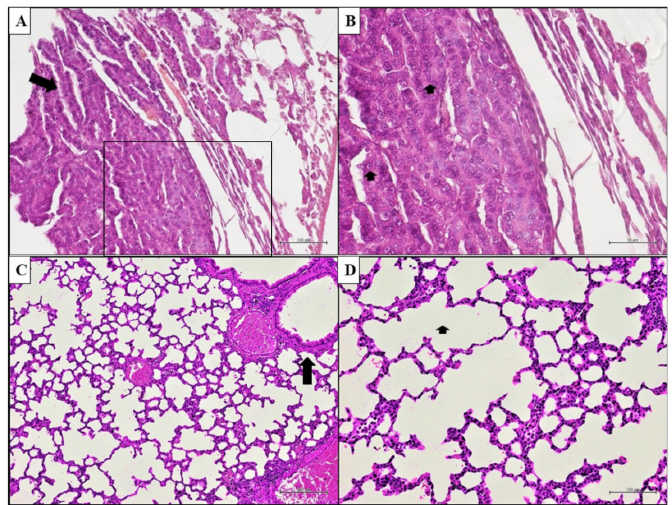
Figure 10. Lung adenocarcinomas in Patz1-knockout mice. ( A ) Representative LUAD with lepidic pattern (left arrow) growing along the surface of the alveolar air spaces of a Patz1 +/ − mouse. The mass is composed of neoplastic cells with loss of polarity, irregularly placed overlapping nuclei, and marked nuclear atypia. ( B ) Higher-power image of the sample shown in A (inset area); better shows the marked pleomorphism and the nuclear atypia: neoplastic cells with nucleomegaly and increased nucleus-to-cytoplasm ratio; nuclei vesicular with fine chromatin and prominent nucleoli (arrowheads). ( C ) Representative normal lung parenchyma in a Patz1 +/+ mouse. Alveolar spaces lined by type 1 and type 2 pneumocytes and a respiratory bronchiole with adjacent arterioles (arrow) are shown. ( D ) Higher magnification of the alveolar epithelium from another area of the same Patz1 +/+ sample shows lung alveoli lined by type 1 and type 2 pneumocytes with poor lymphocytic infiltrate in the alveolar septa (arrow). Hematoxylin & eosin. Scale bars: 50 µ m in ( B ); 100 µ m in ( A , D ); 200 µ m in ( C ).